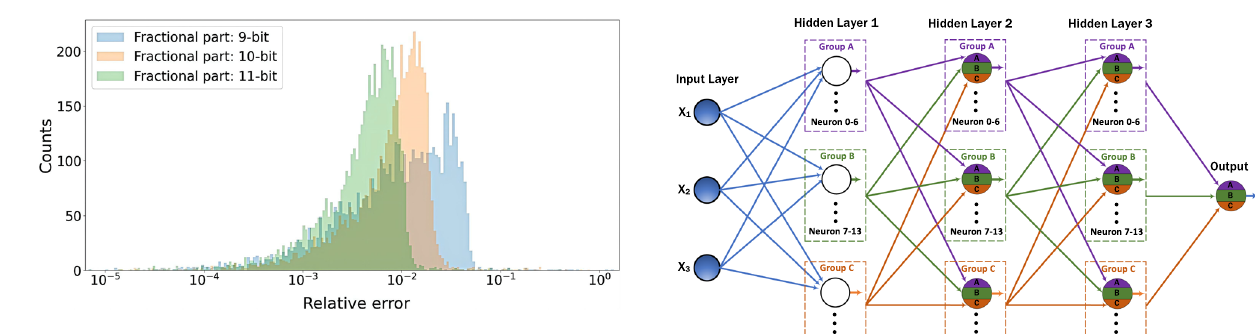
Fig. 10 Errors for network output values computed as the relative dif- ferences between values obtained using the implementation with 16- bit precision and implementation with 32-bit precision. Three different results with the decimal precision of 9, 10 and 11 bits are compared in the plot